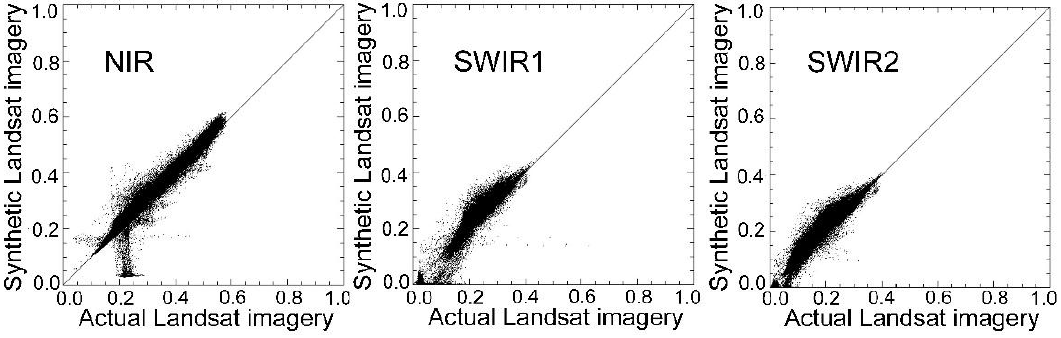
Figure 6. Scatter plots between the actual and synthetic imageries of Landsat using modified spatial and temporal data fusion approach (MSTDFA) with input of Finer Resolution Observation and Monitoring of Global Land Cover (FROM–GLC).